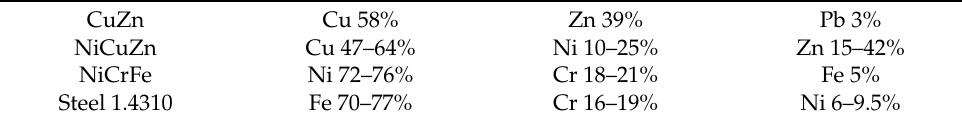
Table 2. List of alloys and its percentage of compositions used for the micromachining.